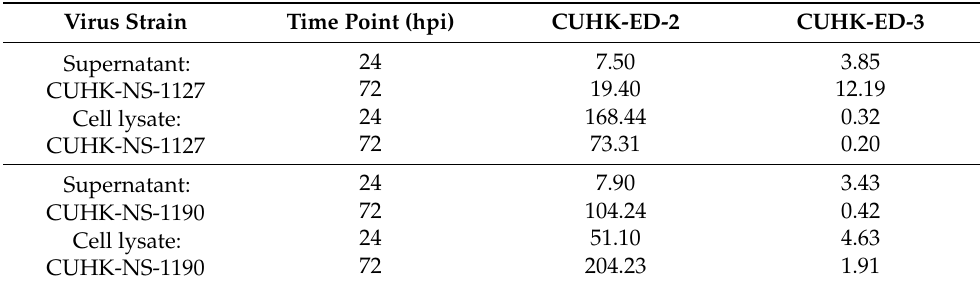
Figure 2. Replication of two Human norovirus (HuNoV) GII.4 Sydney [P31] strains in human intestinal enteroids (HIE) lines CUHK-ED-2 and CUHK-ED-3: The monolayer of each human intestinal enteroids lines was inoculated at a multiplicity of infection of 50 (approximately 3.0 × 10 6 –3.4 × 10 6 genome equivalents/well) with the two strains in two independent experiments (as biological replicates). Norovirus RNA was extracted from the supernatant and cell lysates collected at 1, 24 and 72 h post-inoculation (hpi). Viral RNA copies per well were obtained by a highly sensitive genogroup-specific quantitative reverse transcription polymerase chain reaction (RT-qPCR). The horizontal grey and silver dotted lines indicate the lower detection limit of RT-qPCR at 552 copies per well of supernatant and 342 copies per well of cell lysates, respectively. Se + , indicates secretor positive; A and AB, represent blood groups A and AB, respectively. Table 2. Fold change of norovirus RNA increase in supernatants and cell lysates at 24 and 72 hpi against 1 hpi in four